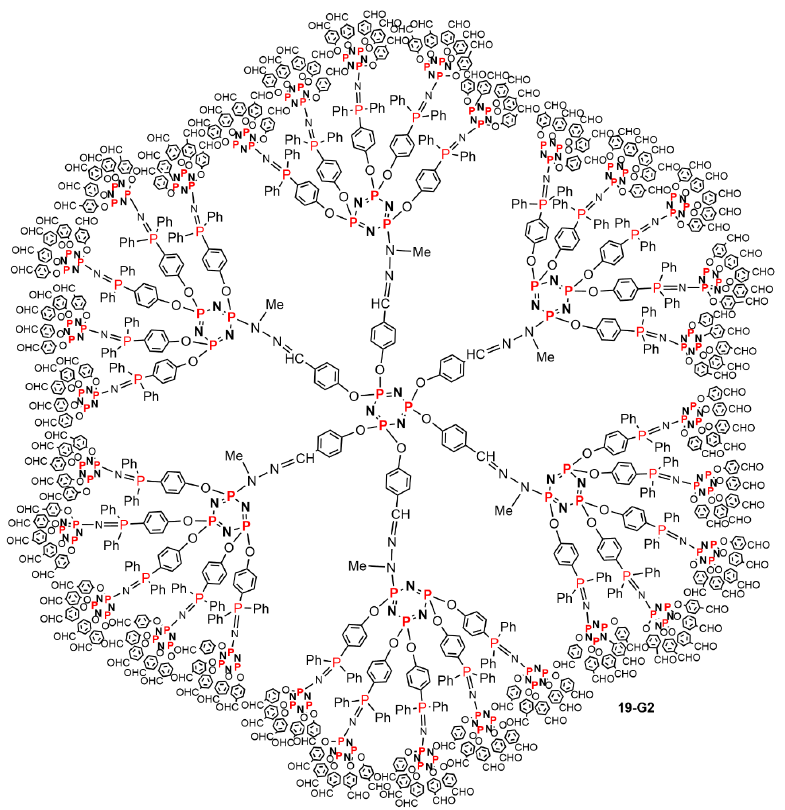
Figure 12. Full chemical structure of dendrimer 19-G2 , functionalized with 150 aldehyde terminal functions, built with AB 5 and CD 5 monomers, for which the linear structure is shown in Scheme 19.